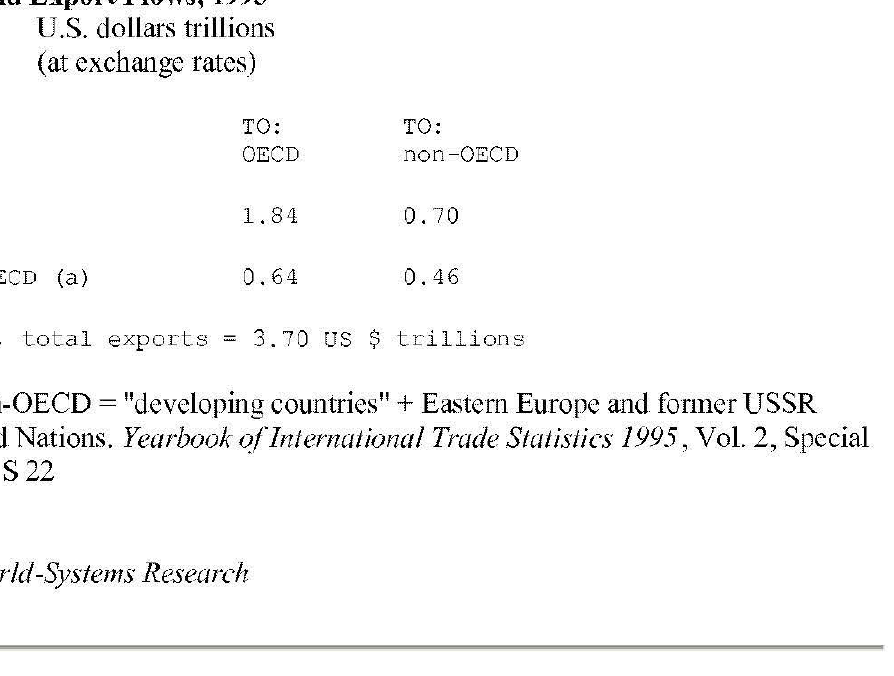
Table 3. World Export Flows,